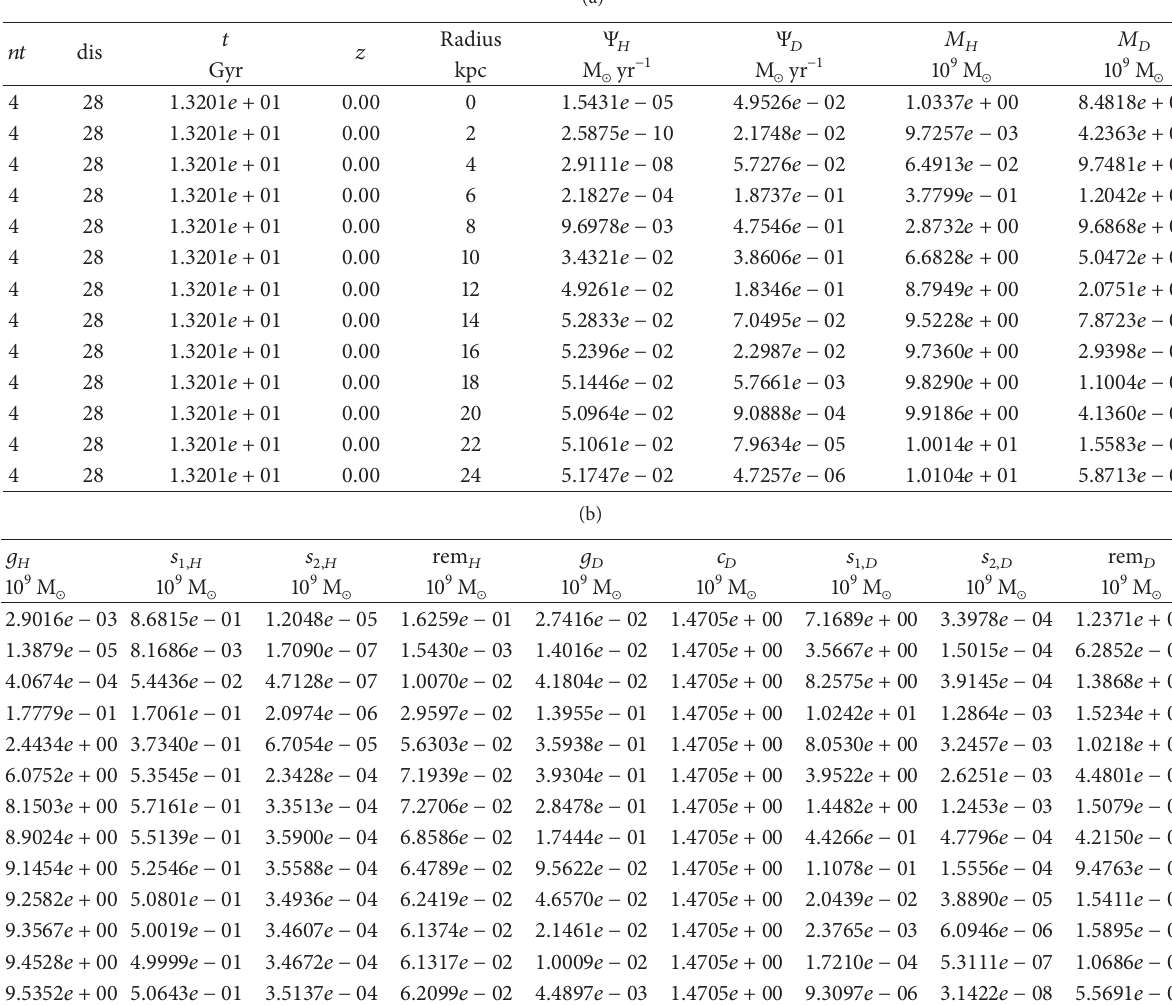
Table 2: Evolution of different phases along the time/redshift for the grid of models. We show as an example the results for the present time of a MWG-like model ( 𝑛𝑡 = 4 , dis = 28 ). The complete table will be available in electronic format.